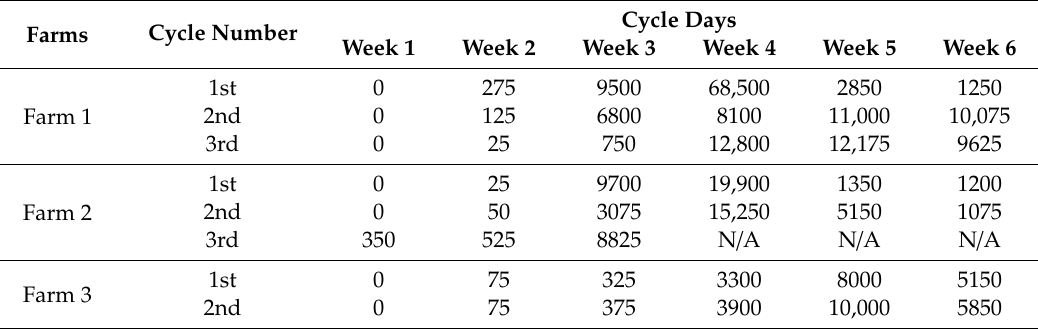
Table 1. Oocyst count in all the three farms during the production